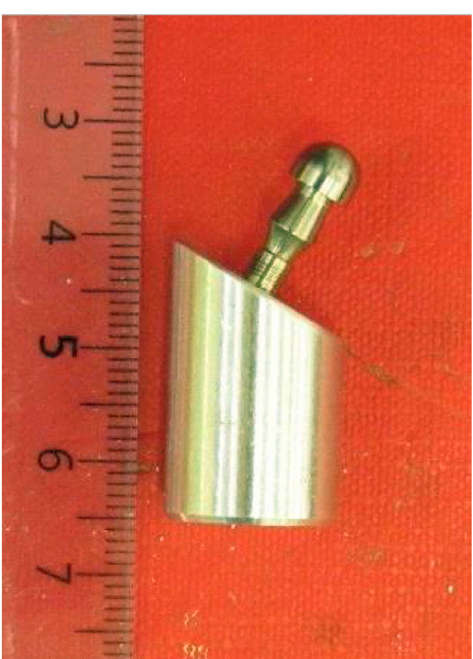
Figure 4. Test configuration used during static characterization. The tests were carried out by controlling the load according to sinusoidal law, with an infinite- length limit set at 5,000,000 cycles. The applied load was set to 10% of the maximum load allowed in the static load experiment. The test would be considered passed if the component did not present structural defects and/or permanent deformations on the surface of the spherical cap; at the same time, it should also be emphasised that the load button must not have been collapsed and/or worn down. The temperature at which the different tests were analysed remained within the range of 20 °C ± 5 °C for all the implants studied (number of assays: n = 3 and n = 3). 2.3. Dimensional Characterisation after the Dynamic Load Study